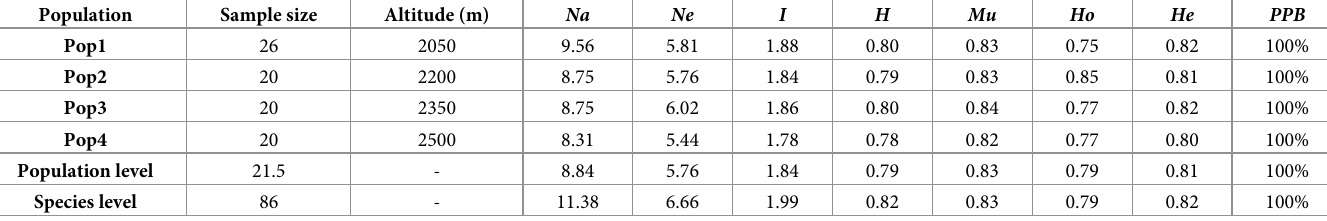
Genetic differentiation As shown in Table 4, Inbred coefficient within population ( F = 0.01), Inbred coefficient of the is total population ( F = 0.04) and Colony coefficient of differentiation ( F = 0.03) all indicated a it st low level of genetic differentiation among populations of wild ancient tea tree, but with high differentiation within populations. In addition, the AMOVA results also revealed that most of the genetic variation (87.16%) existed within the populations and only 12.84% among the Table 3. Genetic diversity parameters of four natural populations of wild ancient tea tree at different altitudes. Population Sample size Altitude